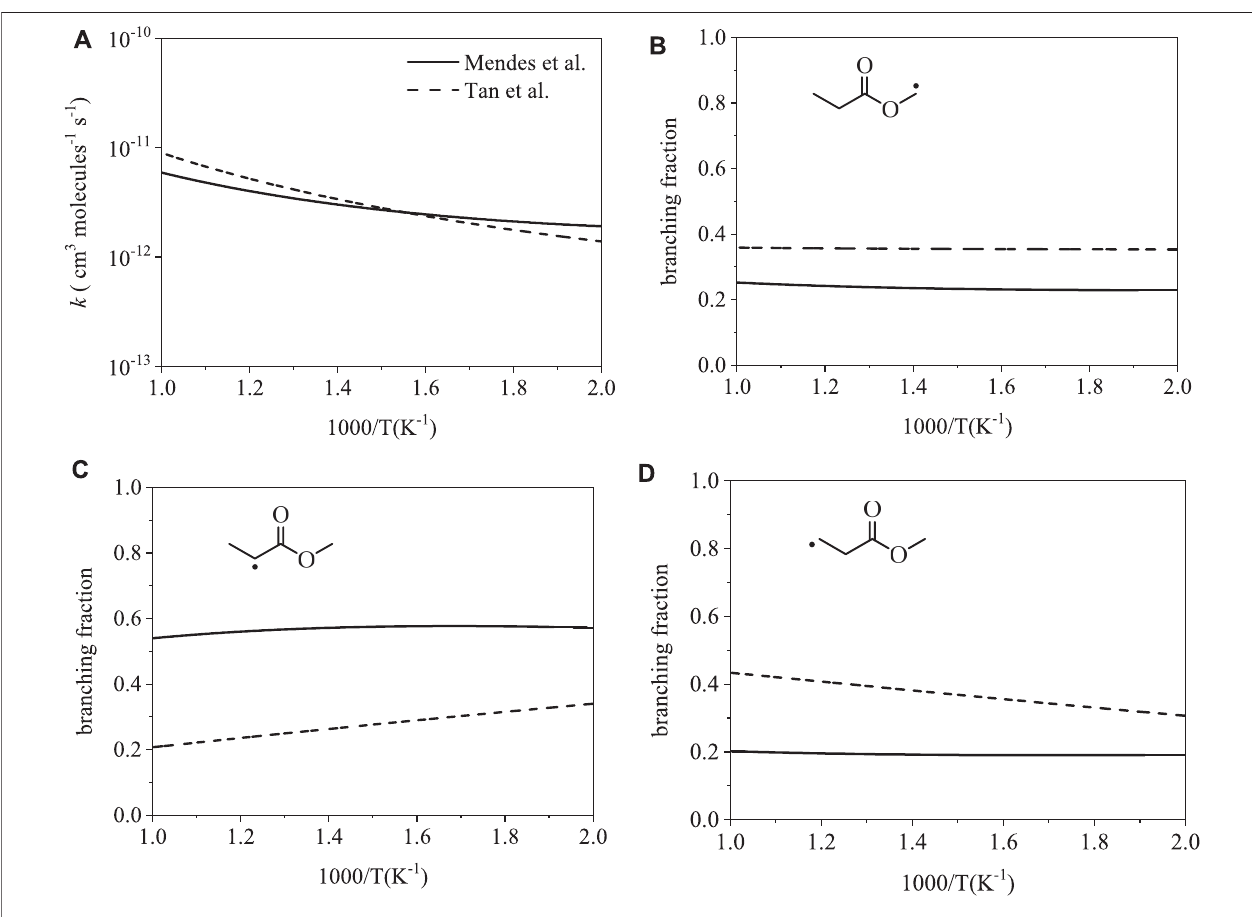
FIGURE 6 | Rate coef fi cients from Mendes et al. (Mendes et al., 2014) and Tan et al. (Tan et al., 2016): (A) total, (B – D) site-speci fi c. Despite the similarity between the total rate coef fi cients, branching fractions for O ̇ H-initiated H-abstraction differ up to a factor of 2.6.